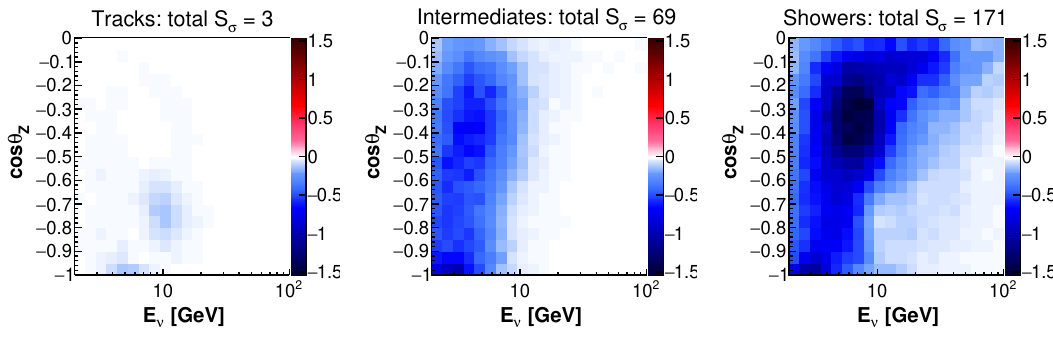
Figure 5 . S σ distribution of the three topologies considered in the analysis (tracks, intermediates and showers) assuming three years of data taking. The colour scale denotes the S σ value for each bin, whereas the total S σ is reported on top of the plots: the high value obtained is due to the normalisation. The sterile neutrino parameters are sin 2 θ 14 = 0 . 05 , sin 2 θ 24 = sin 2 θ 34 = 0 , ∆ m 2 = 1 eV 2 . 41